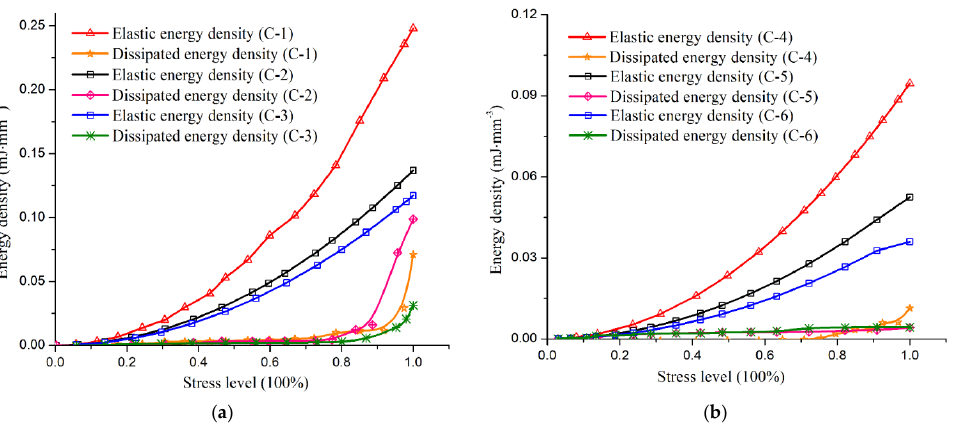
Figure 8. Curves of the energy evolution of coal samples during loading. ( a ) coal sample C-1, C-2 and